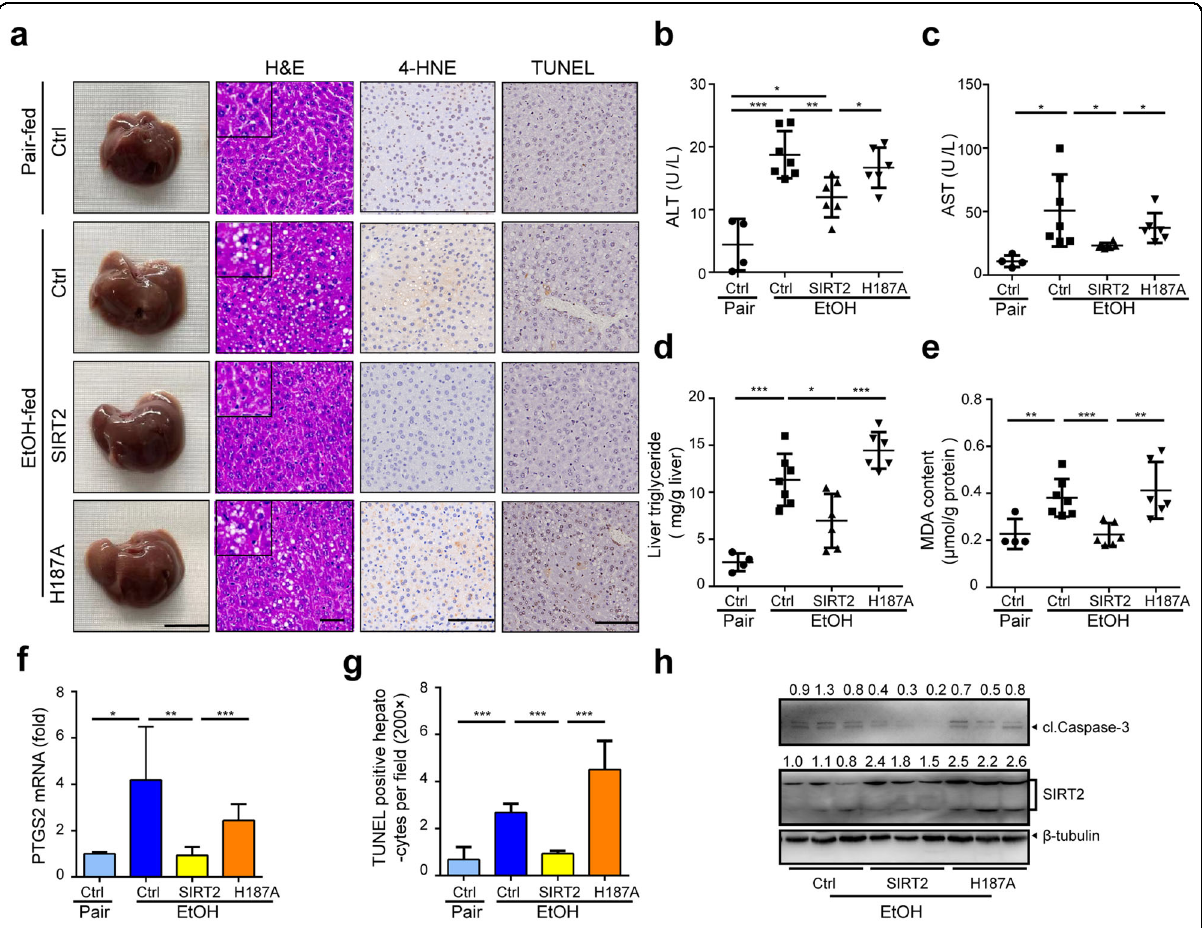
Fig. 3 Hepatocyte-speci fi c SIRT2 overexpression prevents alcoholic liver injury in mice. Male C57BL/6 mice tail injected with AAV8-Ctrl (Ctrl), AAV8-SIRT2 (SIRT2), or AAV8 - SIRT2-H187A (H187A) were treated with pair (Pair) and ethanol diet (EtOH) according to NIAAA model ( n = 7/group). a Images of the indicated livers (scale bar, 1 cm), murine liver staining by H&E (scale bar, 50 μ m), IHC detection of 4-HNE and TUNEL assay (scale bar, 100 μ m). b – d Serum ALT ( b ) and AST ( c ) measurements and TG content ( d ). e – f Hepatic MDA measurements ( e ) and PTGS2 mRNA analysis by qRT- PCR ( f ). g Quantitative analysis of TUNEL-positive hepatocytes (magni fi cation, ×200) in murine livers. h Western blot analysis of cl.Caspase-3 and SIRT2 expression in murine liver tissues. Student ’ s t- test was used for statistical evaluation. Data are shown as means ± SD and are considered statistically signi fi cant at * P < 0.05, ** P < 0.01, and *** P <